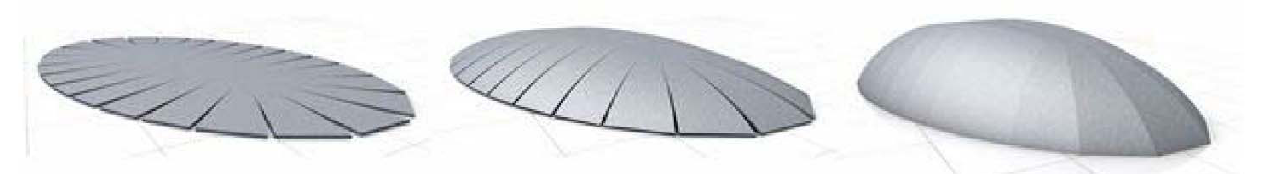
Figure 19: Pneumatic Forming of Hardened Concrete (PFHC) construction method.